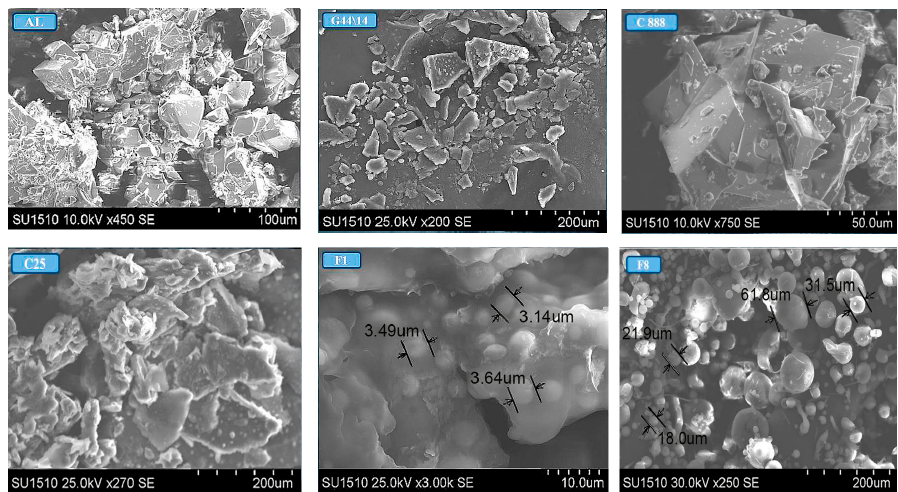
Figure 7. SEM images of raw materials and F1 and F8 AL-loaded SLPs.